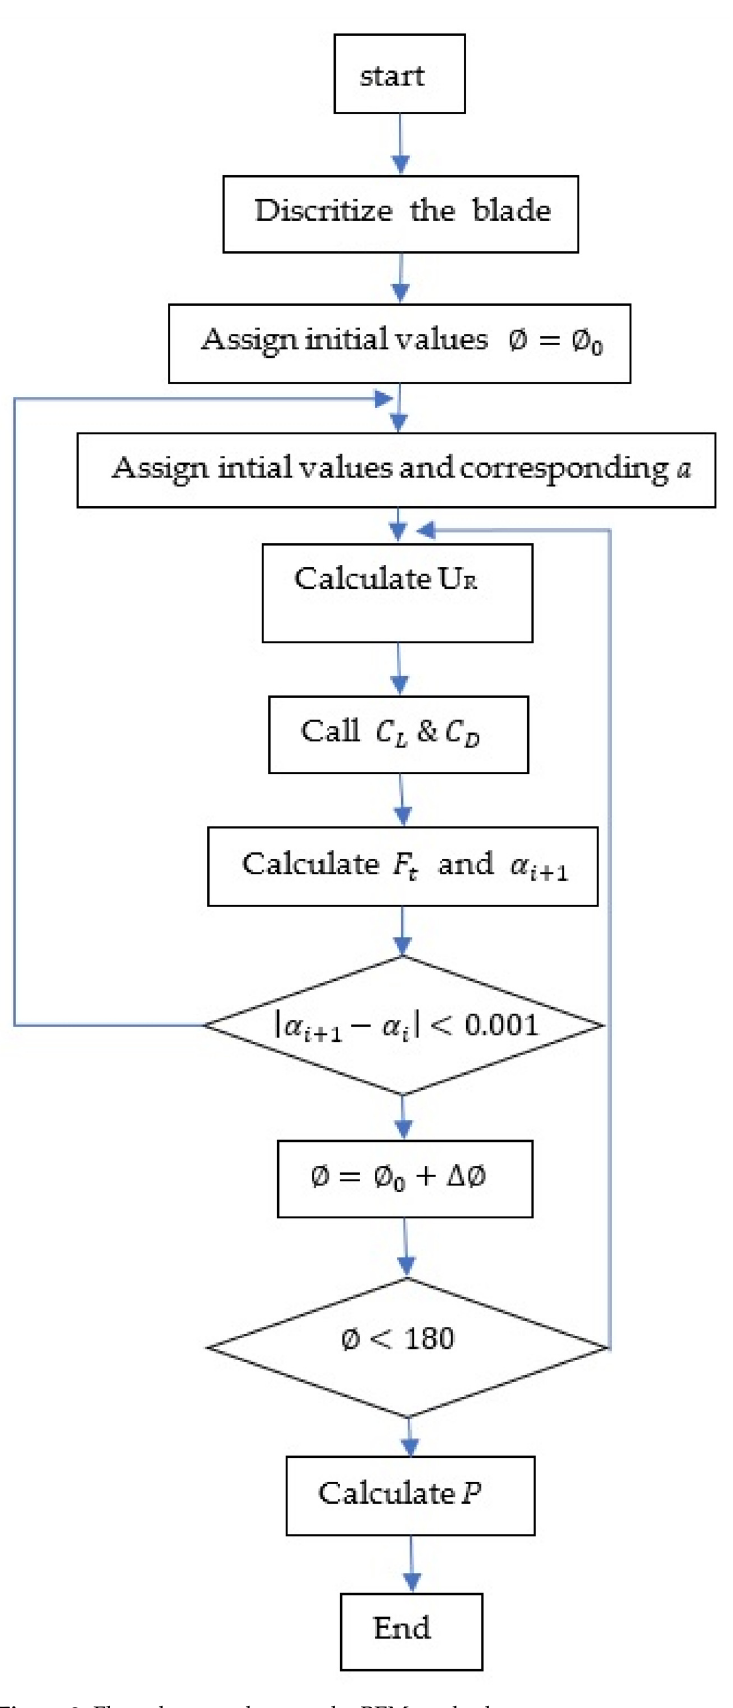
Figure 9. Flow chart used to run the BEM